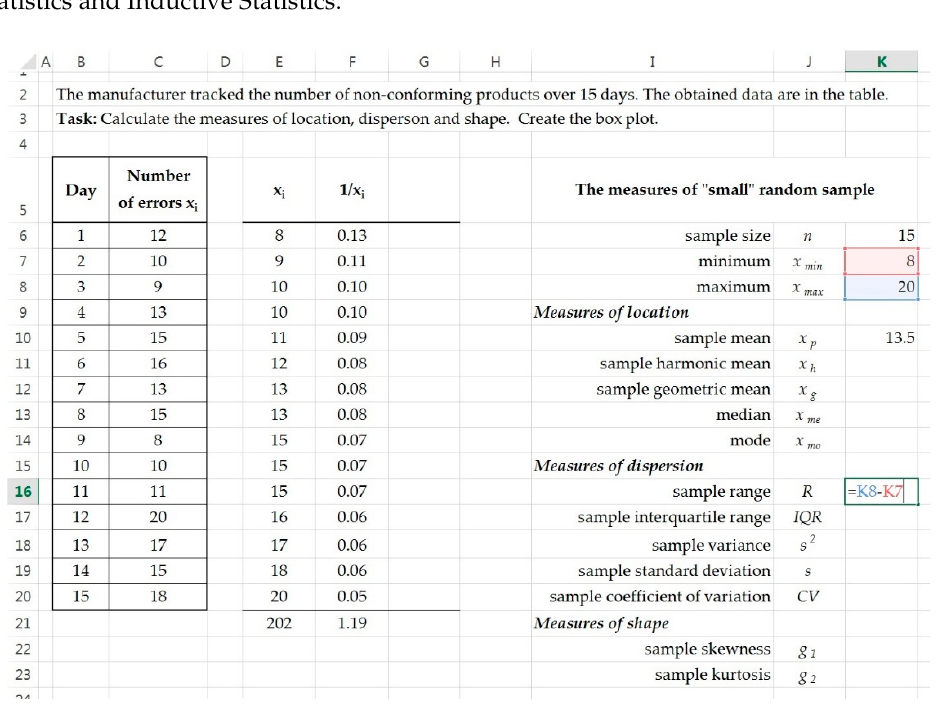
Figure 3. A sample of the example in the numerical exercise.